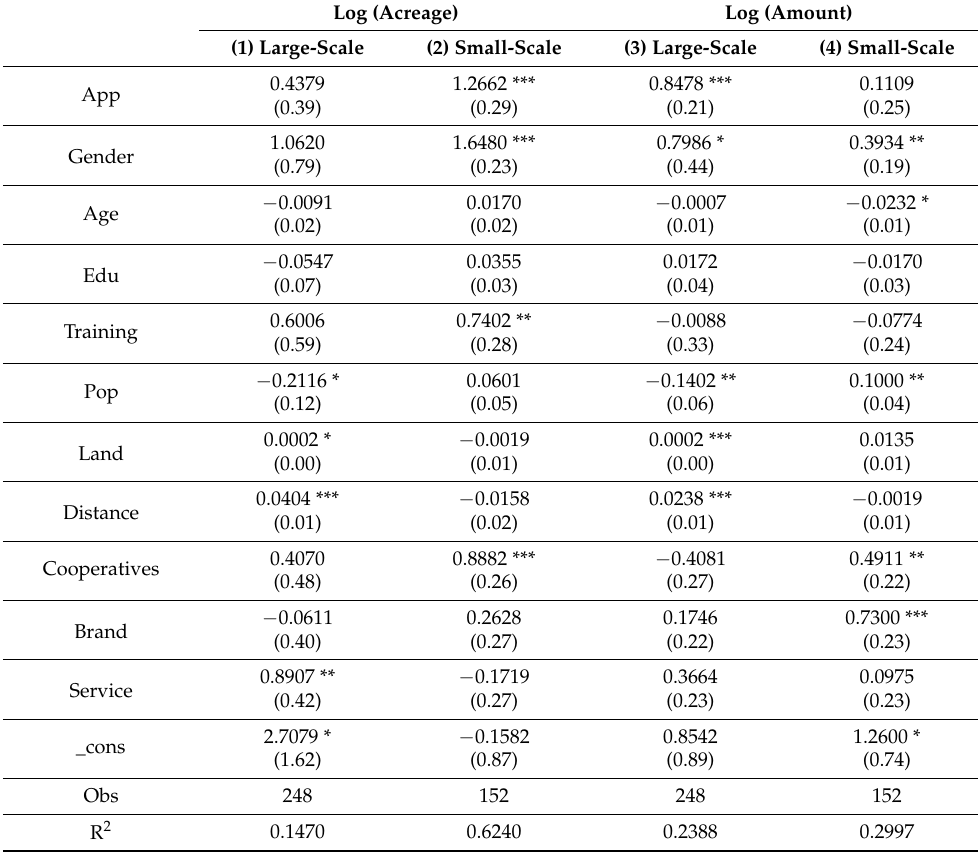
Table 3. Effects of “Zhe’ yang’ shi” on different